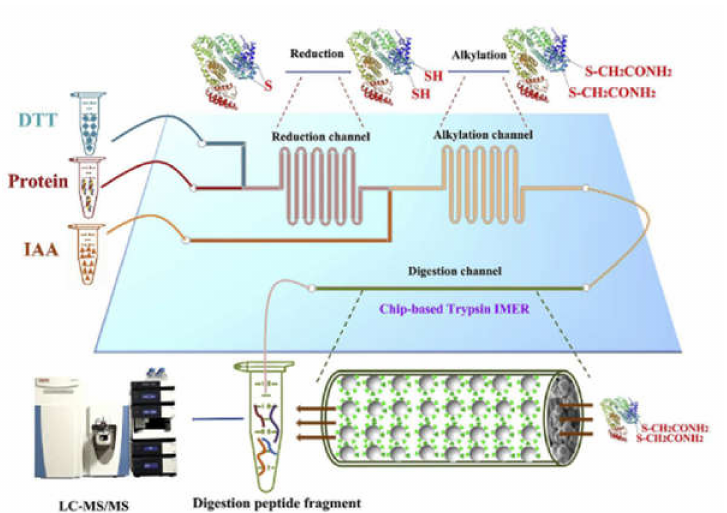
Figure 7. Schematic illustration of the integration of chip denaturation—chip IMER digestion. (Reprinted with permission from [58], published by Elsevier,